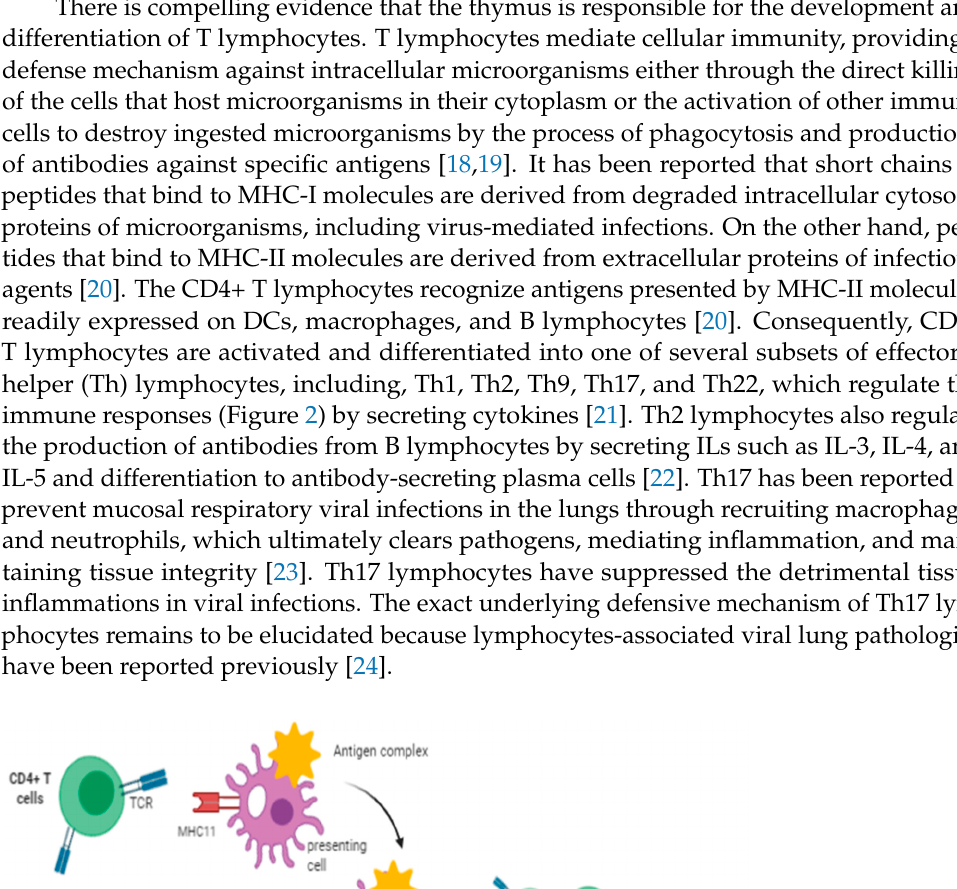
by activated cytotoxic T cells and